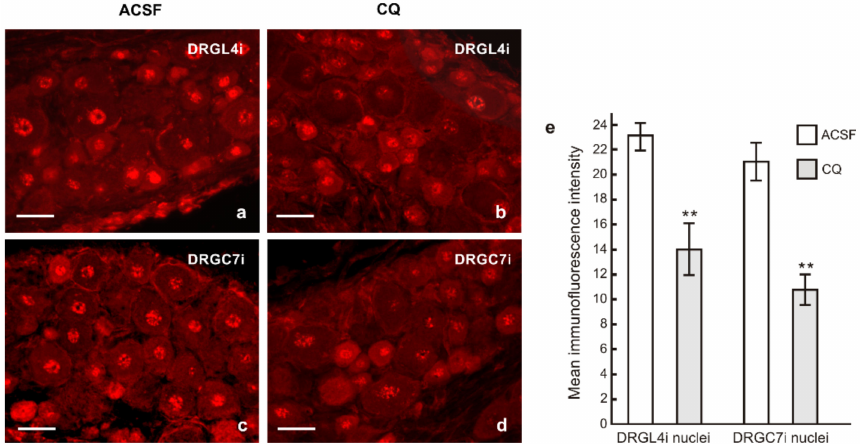
Figure 9. Representative sections of the lumbar (DRGL4i) and cervical DRG (DRGC7i) ipsilateral to the crushed ulnar nerve in rat with prior CSNT for 7 days and intrathecal application of artificial cerebrospinal fluid (ACSF, ( a , c )) or chloroquine (CQ, ( b , d )). Sections were immunostained with rabbit polyclonal anti-STAT3(Y705) and TRITC-conjugated donkey anti-rabbit antibodies under the same conditions to demonstrate nuclear translocation of activated STAT3. Scale bars = 40 µ m. The graph ( e ) shows decreased intensity of STAT3 immunofluorescence in the DRG neuronal nuclei after CQ application. ** Significant difference ( p < 0.01) compared with ACSF in a Kruskal–Wallis ANOVA